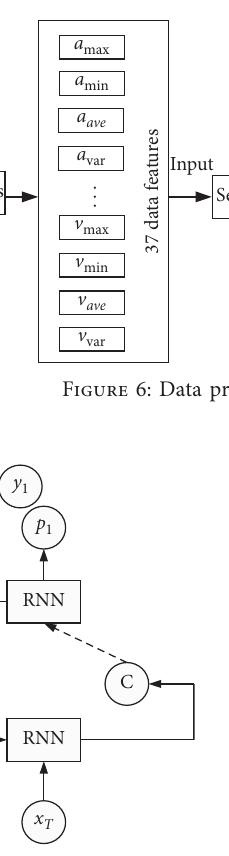
Figure 7: The Seq2Seq decoder-encoder based